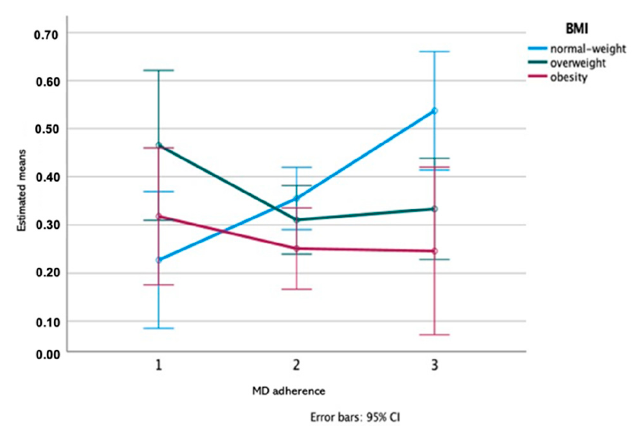
Figure 4. MD adherence * BMI interaction plot for salivary Amy_protein concentration: a two-way ANOVA ( n = 122; MD adherence * BMI interaction effect p = 0.019; Eta partial squared = 0.11; power of the test = 80%).